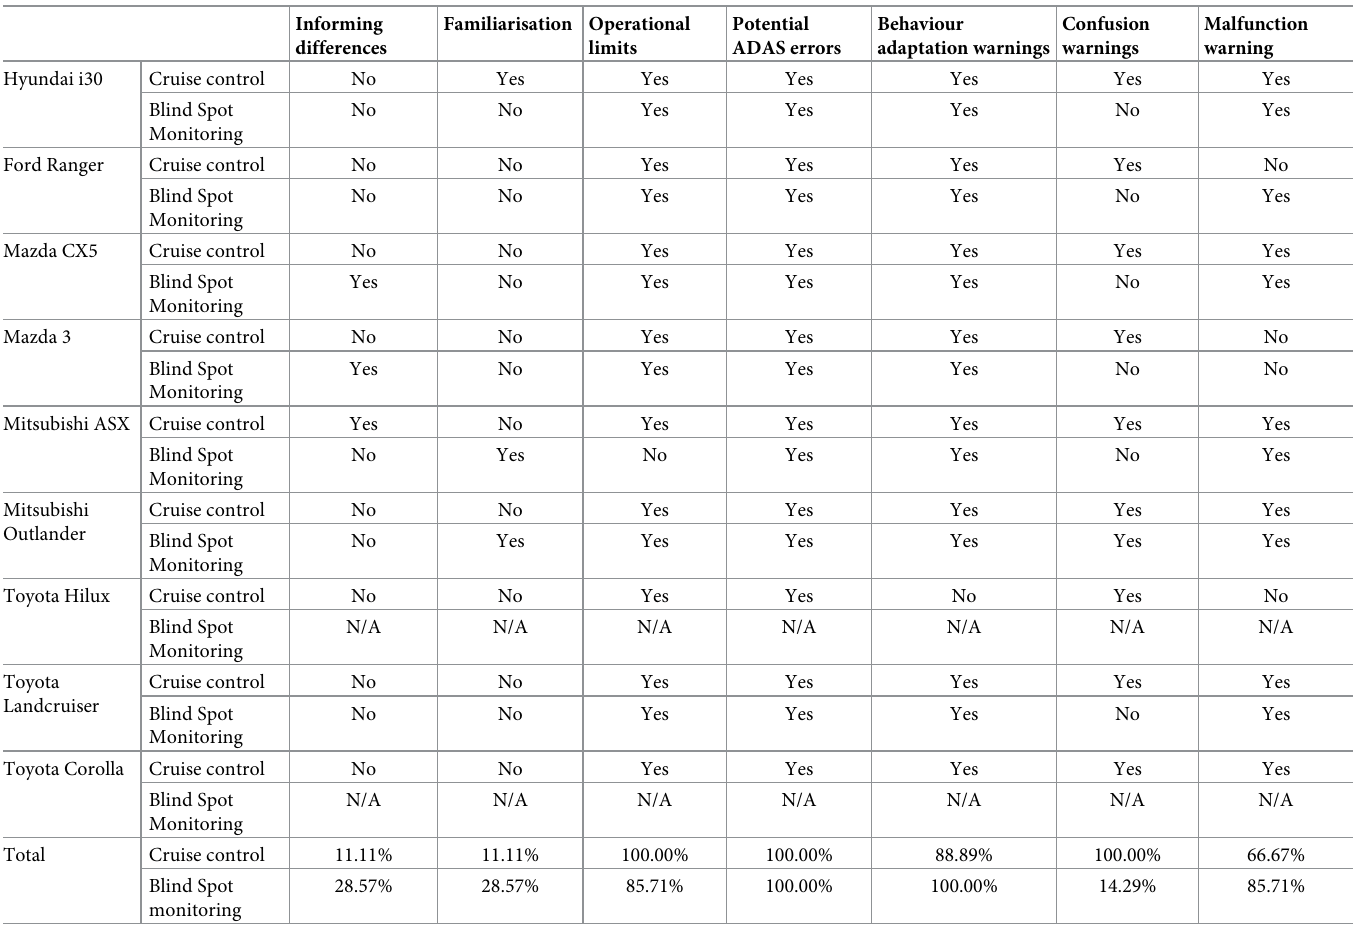
Table 3. Summary of qualitative analysis of ADAS by vehicle and